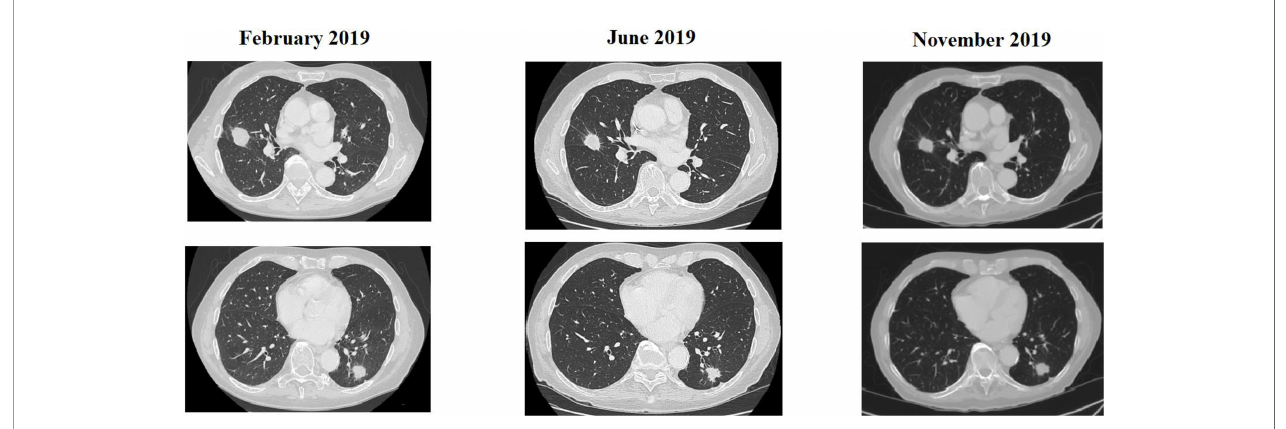
FIGURE 3 | CT scan of a patient treated with rechallenge strategy after >2 prior lines of treatment and an anti-EGFR free interval >